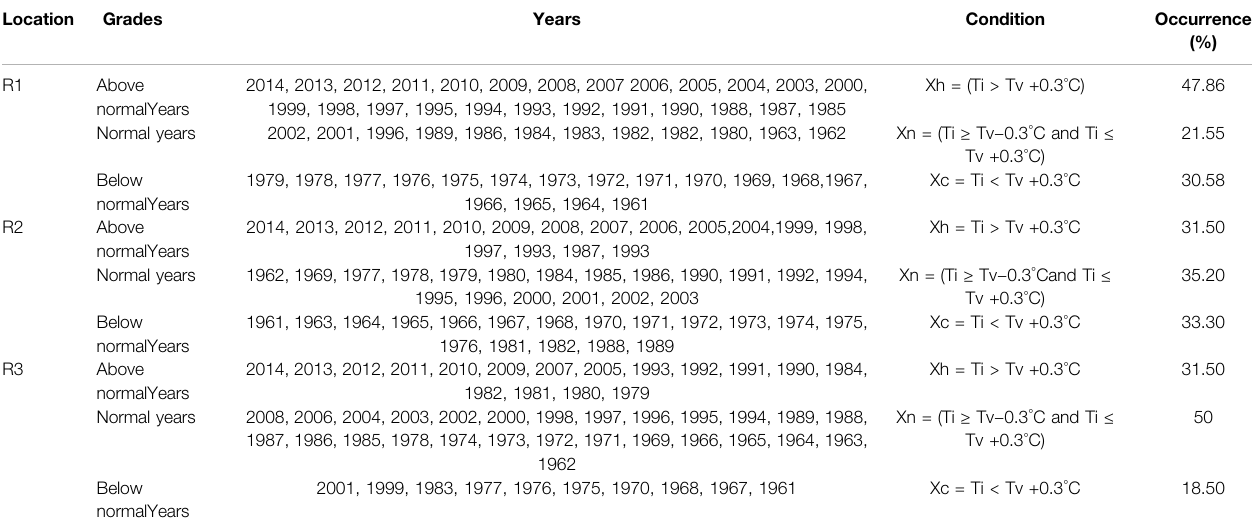
TABLE 3 | Occurrence of abnormal temperatures (above, normal and below) in R1, R2 and R3 based on observed data during 1961 – 2014.